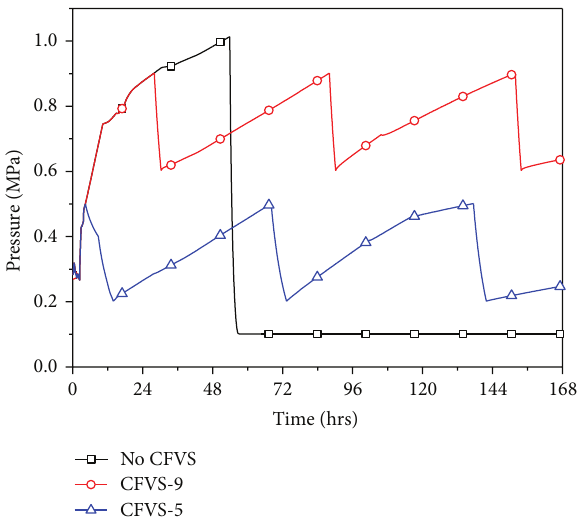
Figure 10: Comparison of fractional release of CsI in